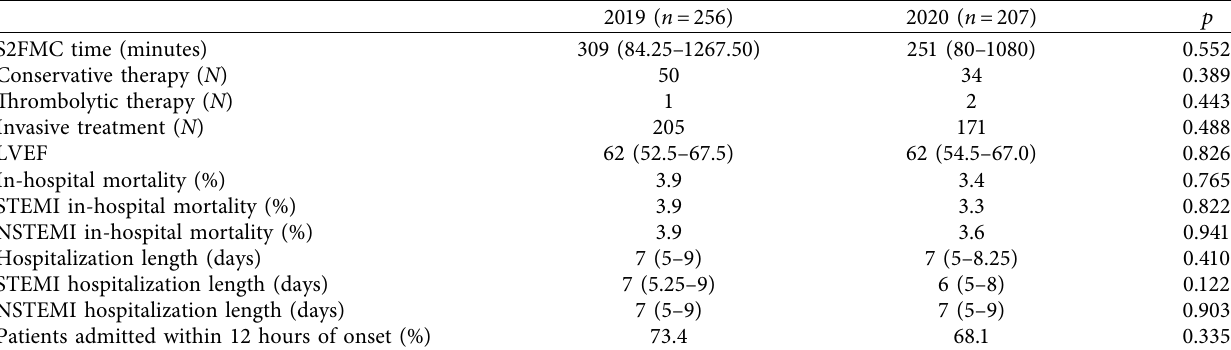
Table 2: Time segment and prognosis of AMI inpatients.